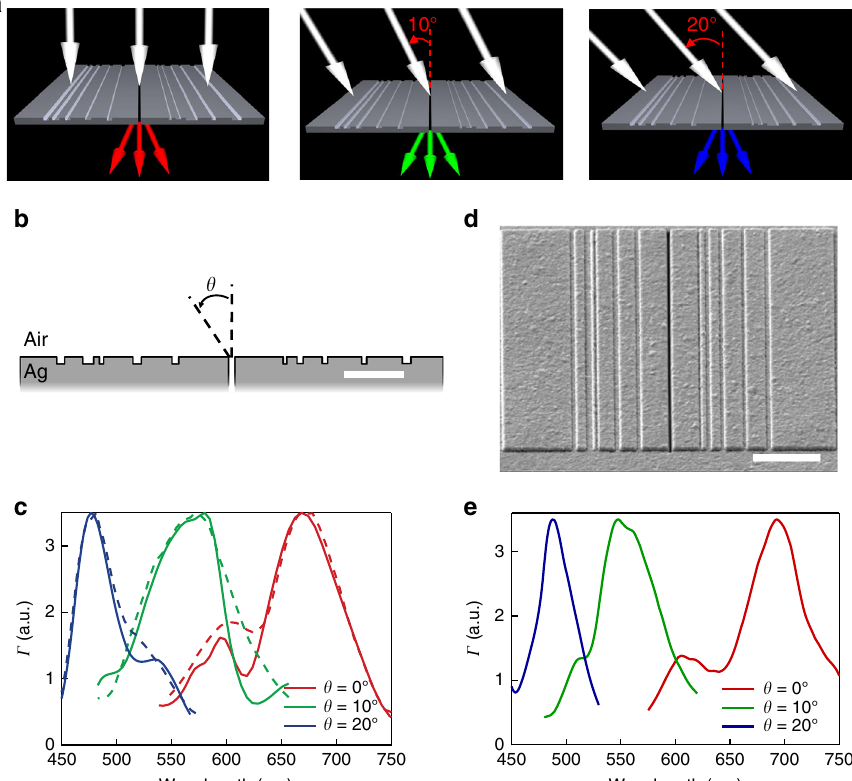
Fig. 2 Aperiodic directional RGB colour- fi lter. a Schematic illustration of the angle-dependent light transmission characteristics of an angularly selective aperiodic RGB colour fi lter. The device is targeted to transmit red light at an incidence angle θ = 0°, green at θ = 10°, and blue at θ = 20° when illuminated with a TM polarized white-light laser source. The device consists of a subwavelength-width linear slit surrounded by fi ve grooves each on both sides within a total lateral device dimension of ≤ 10 μ m. b Model predicted surface cross-section pro fi le of the optimized device at a Ag-air interface. Scale bar represents 1 μ m. c Relative transmission ( Γ ) spectra calculated using the interference model of Eq. (3) (solid lines) and FDTD simulations (dashed lines) show remarkable agreement, and demonstrate the unique spectral transmission characteristics of the device. d Scanning-electron-microscope (SEM) image of the patterned surface of the aperiodic slit-groove array device taken at 38° from the surface normal. The device is fabricated using the procedure described in Methods section and outlined in Supplementary Fig. 6. Horizontal scale bar represents 2 μ m. e Experimentally measured Γ spectra at three angles of incidence for the fabricated device. The spectral characteristics of the fabricated device, namely: linewidth, optical contrast, and spectral